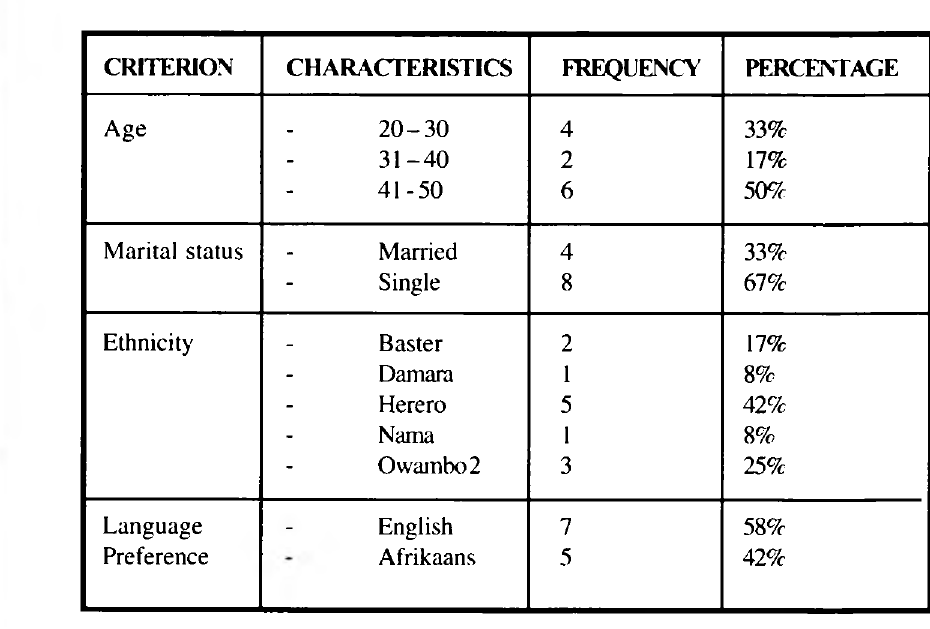
TABLE 1.1 Demographic information of the sample (N=12)